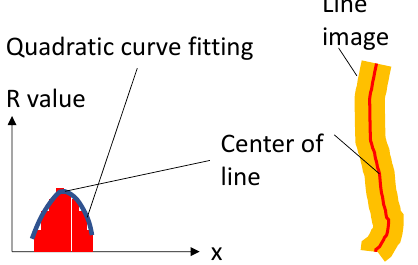
Figure 4. Quadratic curve fitting of the image of the ultrafine wire.